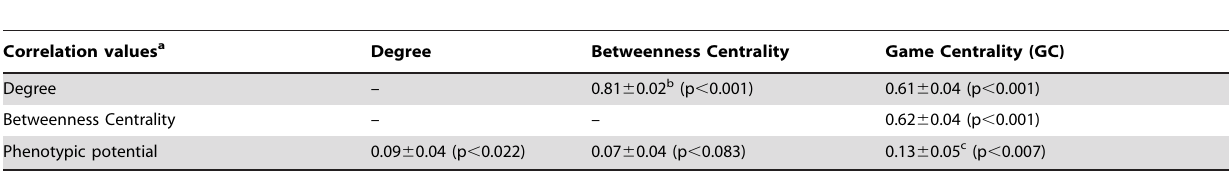
Table 2. Correlations of game centrality (GC) with degree, betweenness centrality and phenotypic potential of proteins in a high fidelity yeast